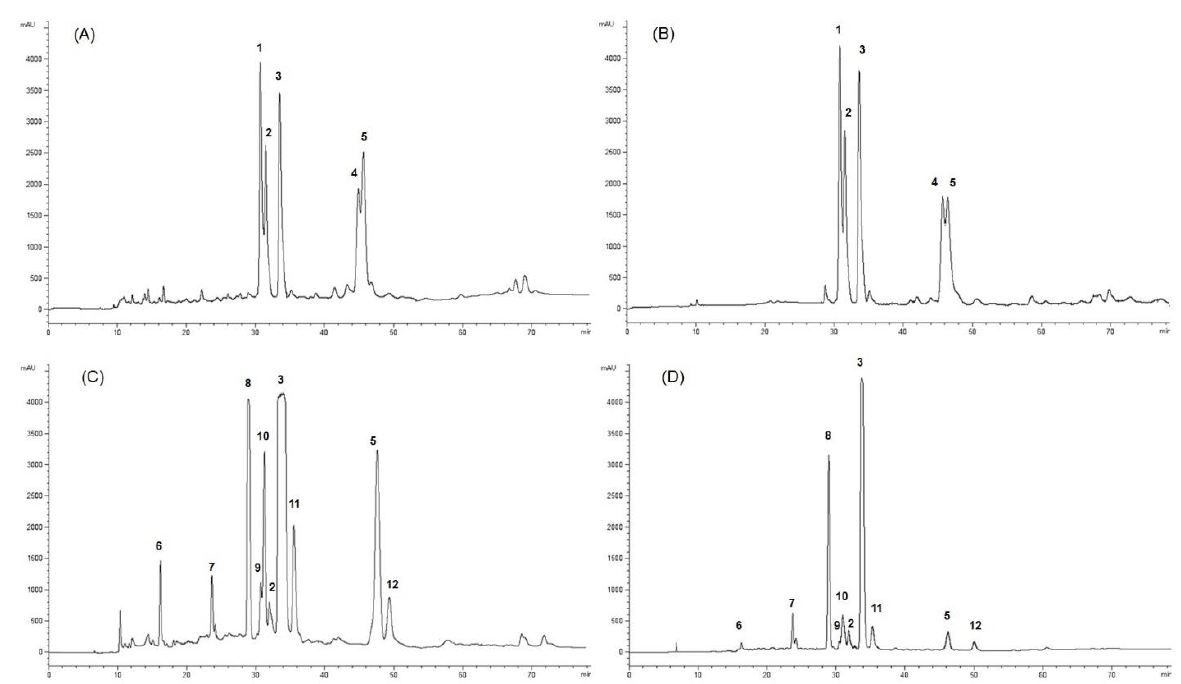
Figure 2. HPLC-UV chromatograms of G. mangostana extracts. ( A ) chloroform extract of arils, ( B ) methanol extract of arils, ( C ) chloroform extract of shells, and ( D ) methanol extract of shells. Table 1. 13 C NMR Data (150 MHz MeOH- d 4) for Compounds 1 – 12 .